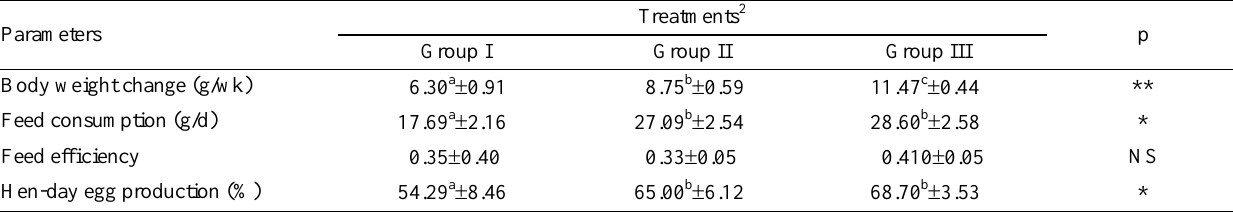
Table 2. The effect of different doses of dietary L-ascorbic acid (L-AA) supplementation on production performance of laying Japanese quail at low ambient temperature (10.47  C)